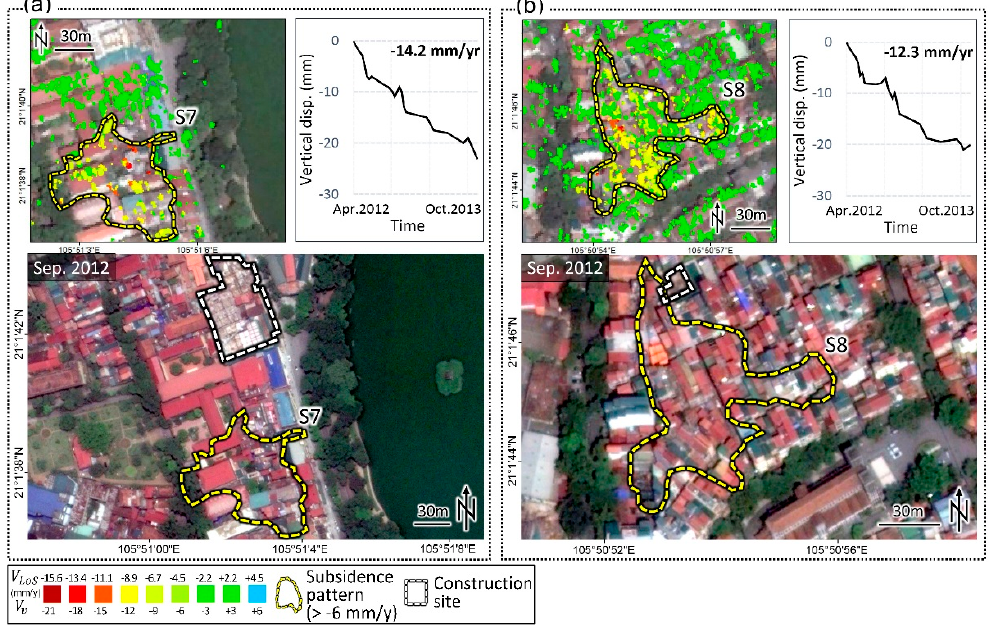
Figure 8. Average for April 2012–November2013. LoS velocity map, temporal evolution chart and optical image represent location of subsidence pattern and construction sites in ( a ) Hang Trong (S7) and ( b ) Tho Xuong (S8). Characters in parentheses denote the label of subsidence patterns in Figure 4.